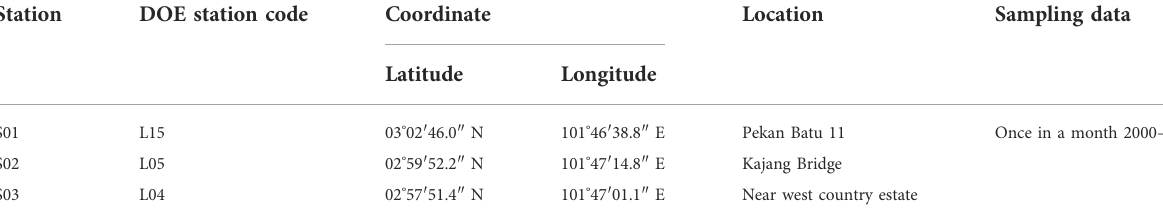
TABLE 1 Coordinates of selected sampling water quality monitoring station.